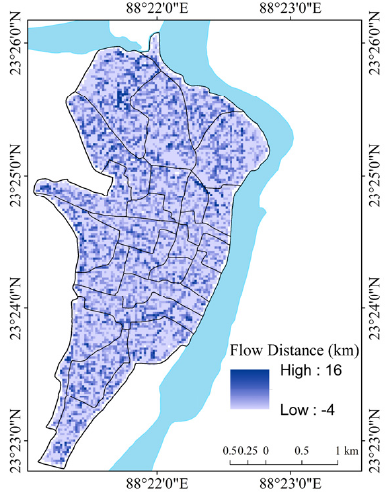
Figure 32. Flow distance (2015).